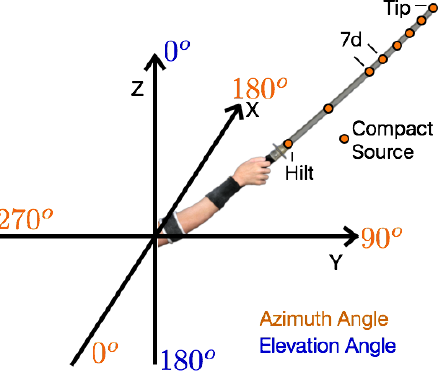
Figure 2. Position of 8 compact sources and coordinates used in the sword model.